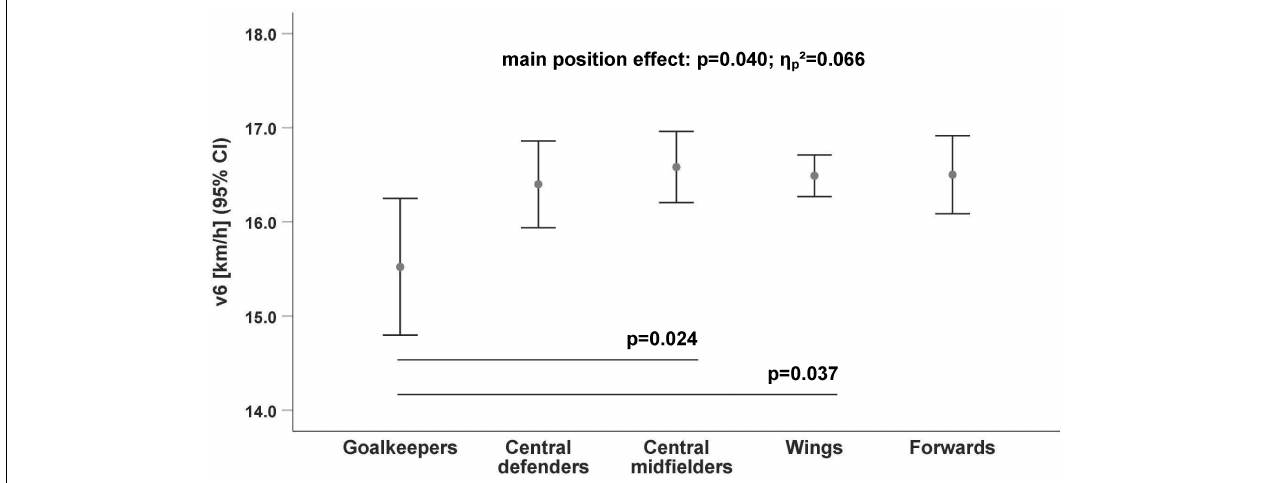
FIGURE 3 | Differences in running velocity by playing position at the 6 mmol/l lactate threshold (v6). Cl, Confidence Interval. TABLE 3 | Differences in running velocities [Mean ± SD; (km/h)] at lactate thresholds by playing position ( p < 0.05). Lactate threshold GK ( n = 11) CD ( n = 25) CM ( n = 37) WI ( n = 55) FW ( n = 24) p η 2 p 2 mmol/l 10.7 ±